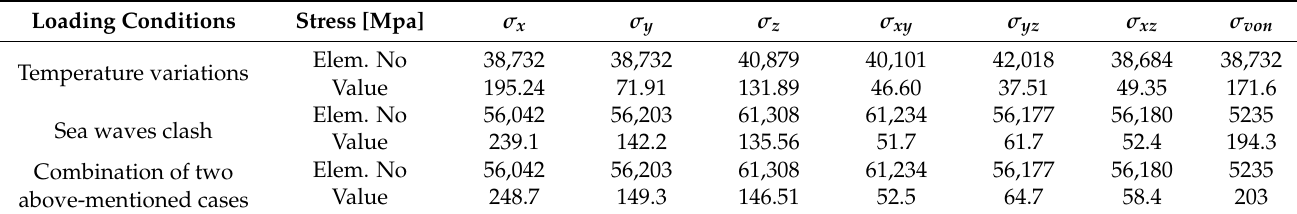
Table 5. Elements with higher stress components and equivalent stress apt to fatigue